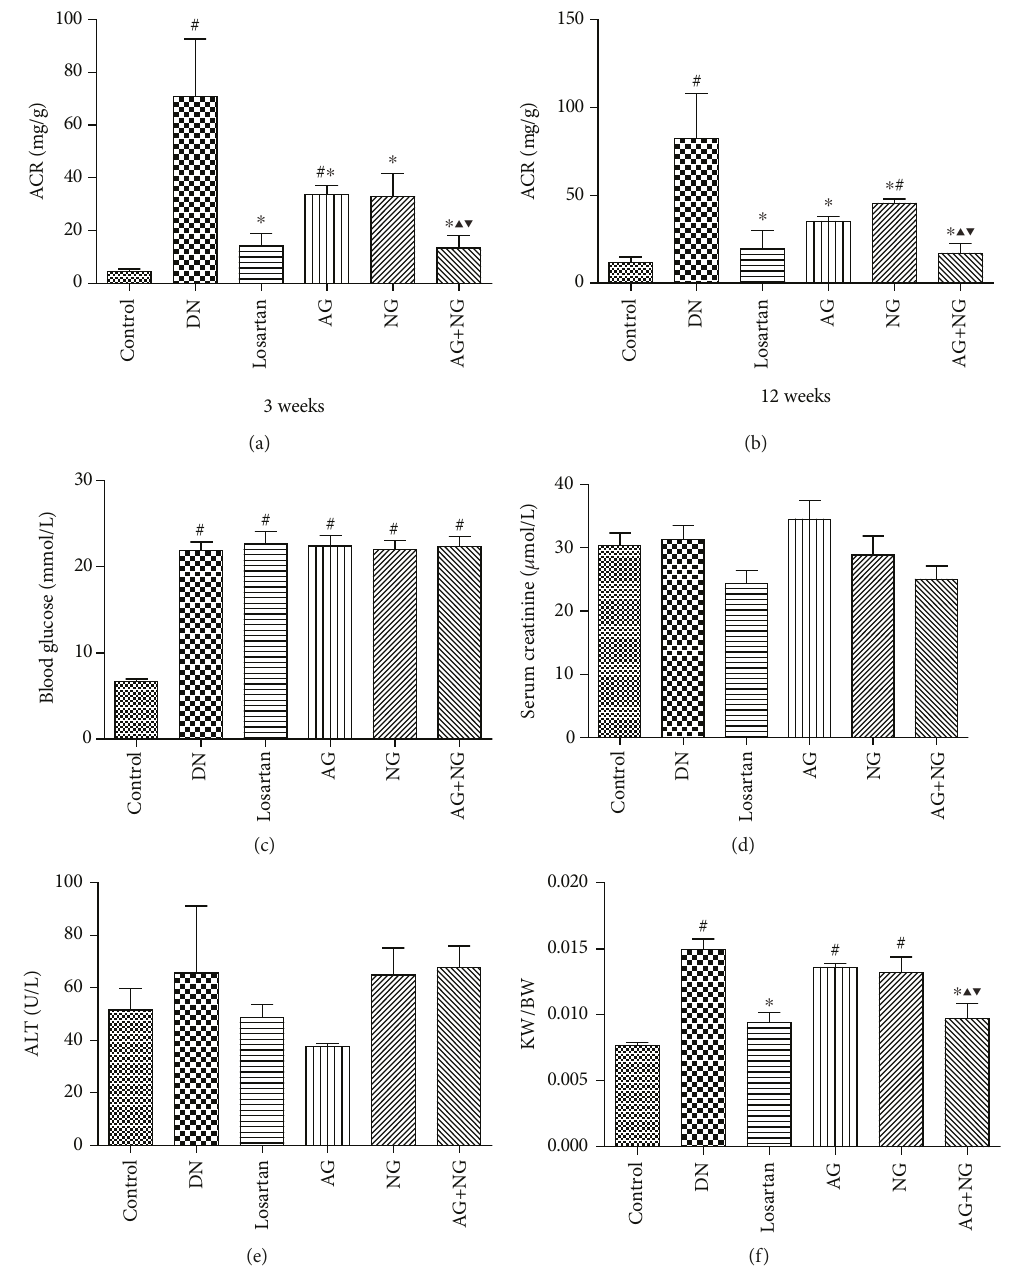
Figure 1: E ff ects of AG and NG on physical and biochemical parameters in diabetic rats. ACR in diabetic rats after treatment with AG and NG for 3 weeks (a) and 12 weeks (b). Blood glucose (c) after STZ injection. Serum creatinine (d), ALT (e), and KW/BW (f) after treatment with AG and NG for 12 weeks. ACR: albuminuria/creatinine ratio; ALT: alanine aminotransferase; KW/BW: kidney weight per body weight ratio; control: normal control rats; DN: STZ-induced diabetic rats; losartan: DN rats treated with losartan; AG: DN rats treated with Astragalus membranaceus; NG: DN rats treated with Panax notoginseng; AG+NG: DN rats treated with Astragalus membranaceus plus Panax notoginseng. Results were expressed as the mean ± SD ( n = 6 ). # P < 0 05 vs. control group, ∗ P < 0 05 vs. DN group, ▲ P < 0 05 vs. AG group, ▼ P < 0 05 vs. NG